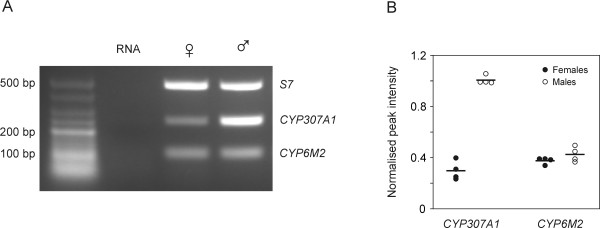
Semi-quantitative RT-PCR validation of selected microarray data. Gene expression levels of CYP307A1 and CYP6M2 between females and males of the susceptible Kisumu strain were compared. (A) Peak intensities of amplified cDNA products of the two target mRNAs were measured and normalised by the internal control, the ribosomal S7 product. Primers used to amplify cDNA are shown in Table 1. (B) Measurements were taken from four biological replicates for each sex (15 one-day adult mosquitoes per replicates). Dots represent normalised peak intensities for each replicate. Horizontal bars show mean values. CYP307A1 shows a 3.4-fold over-expression in males (one-sided t-test, p < 0.001) whereas CYP6M2 was 1.1-fold over-expressed in males but statistically not significant (one-sided t-test, p = 0.3).